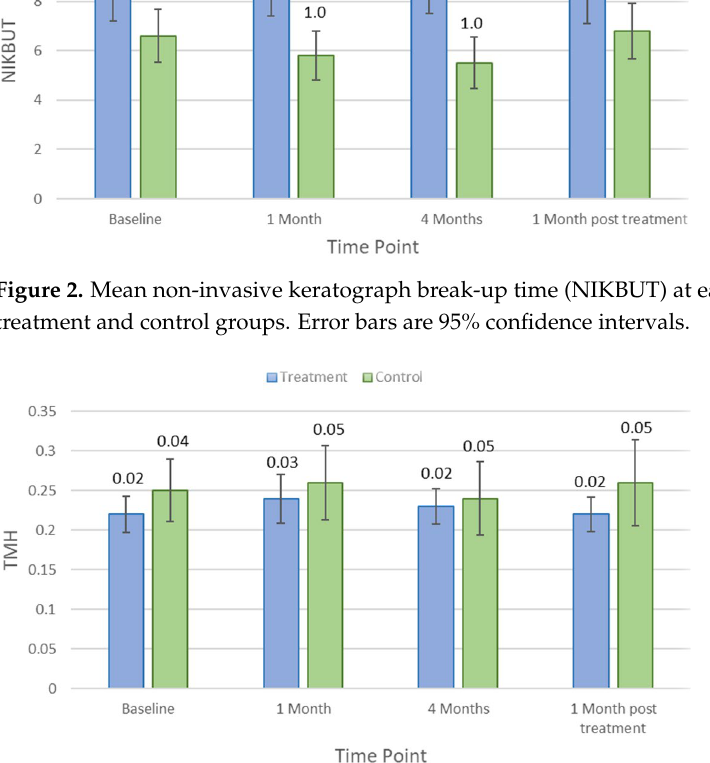
Figure 3. Mean meniscus assessment height (TMH) at each study time point in the treatment and control groups. Error bars are 95% confidence intervals.